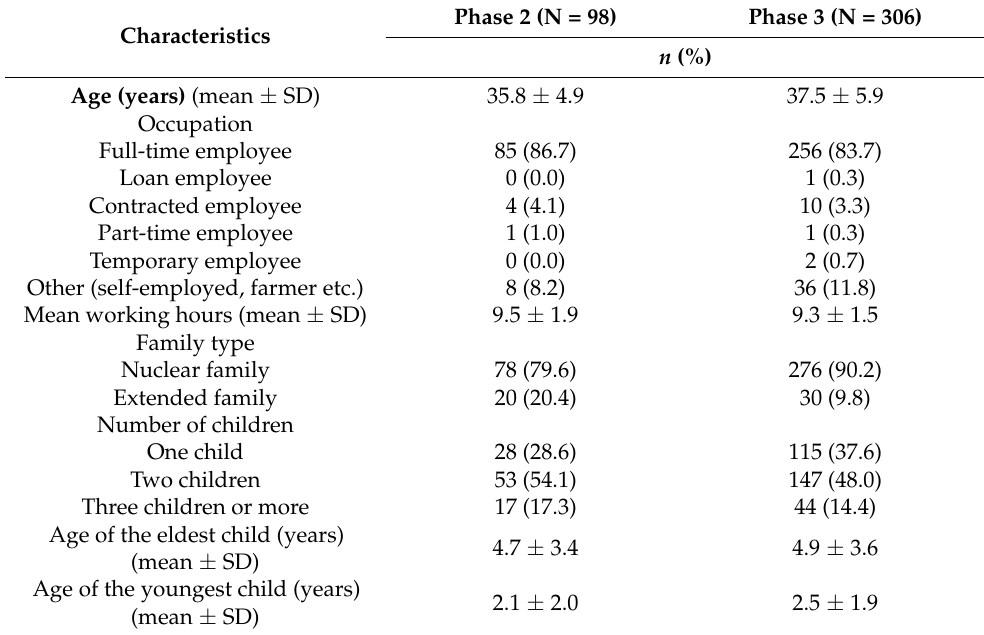
Table 1. Participant